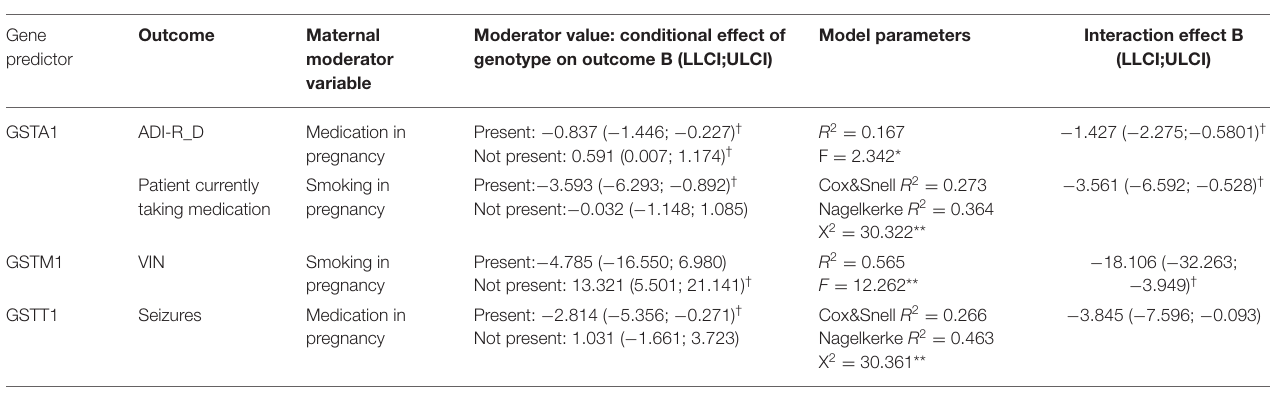
TABLE 4 | Moderation analysis (controlling for other genotypes and age). Gene